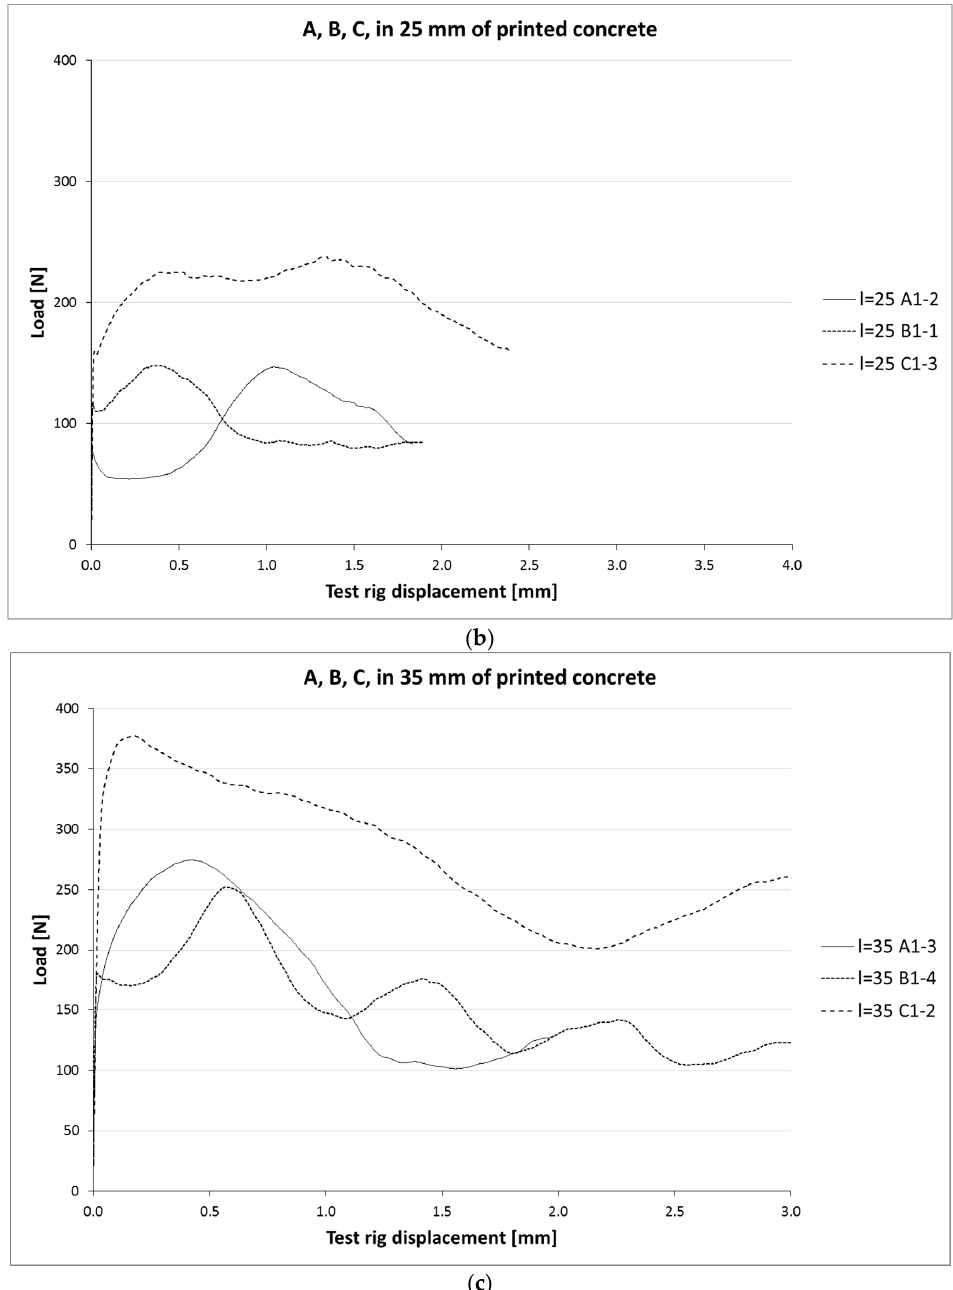
Figure 7. ( a ) Load-slip curves of pull-out tests of printed samples with l cs = 15 mm. For each series, one curve is shown (for reasons of clarity), considered representative for that particular series. It should be noted that the individual behaviour can differ significantly, as is also clear from the coefficients of variation. ( b ) Load-slip curves of pull-out tests of representative printed samples with l cs = 25 mm; ( c ) Lload-slip curves of pull-out tests of representative printed samples with l cs = 35 mm.